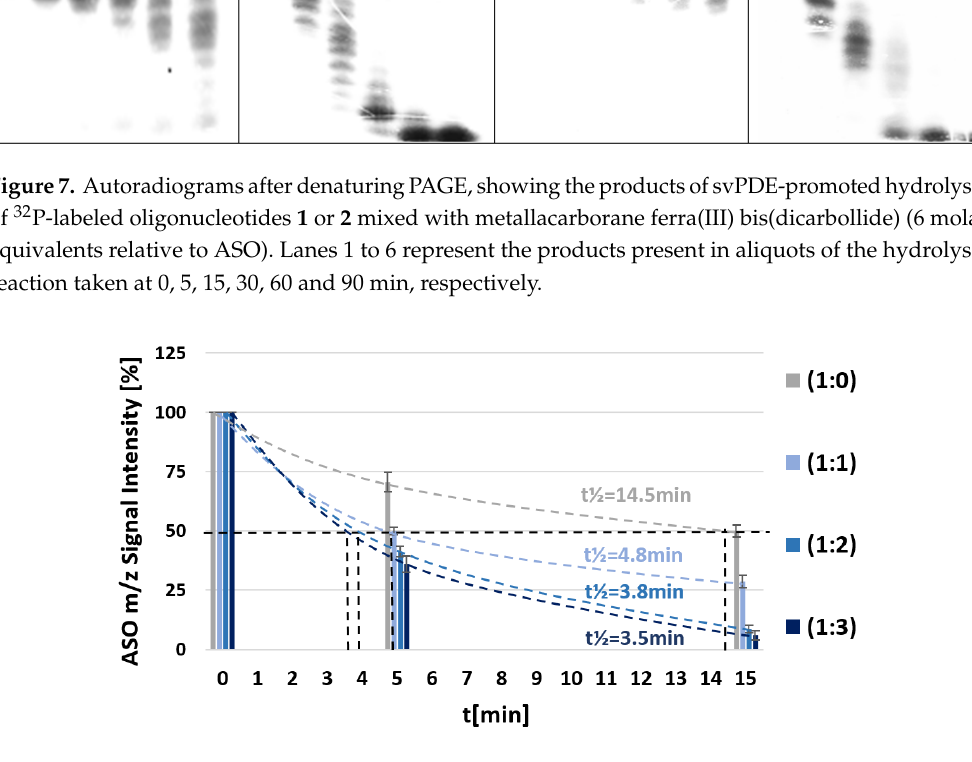
Figure 8. Analysis of the hydrolysis rate of oligonucleotide 1 (1 equiv.) in the svPDE-assisted reaction carried out in the presence of 0, 1, 2 or 3 equivalents of metallacarborane. The % content of intact 1 was calculated after 0, 5 and 15 min of hydrolysis based on the relative peak intensities in the MALDI-TOF MS spectra. The sums of the relative intensity of the peaks corresponds to the intact oligomers and their two major fragments (12 nt and 11 nt) were taken as 100% at each time point. SD± values are marked. The roughly estimated T 1/2 values were assessed, as shown.